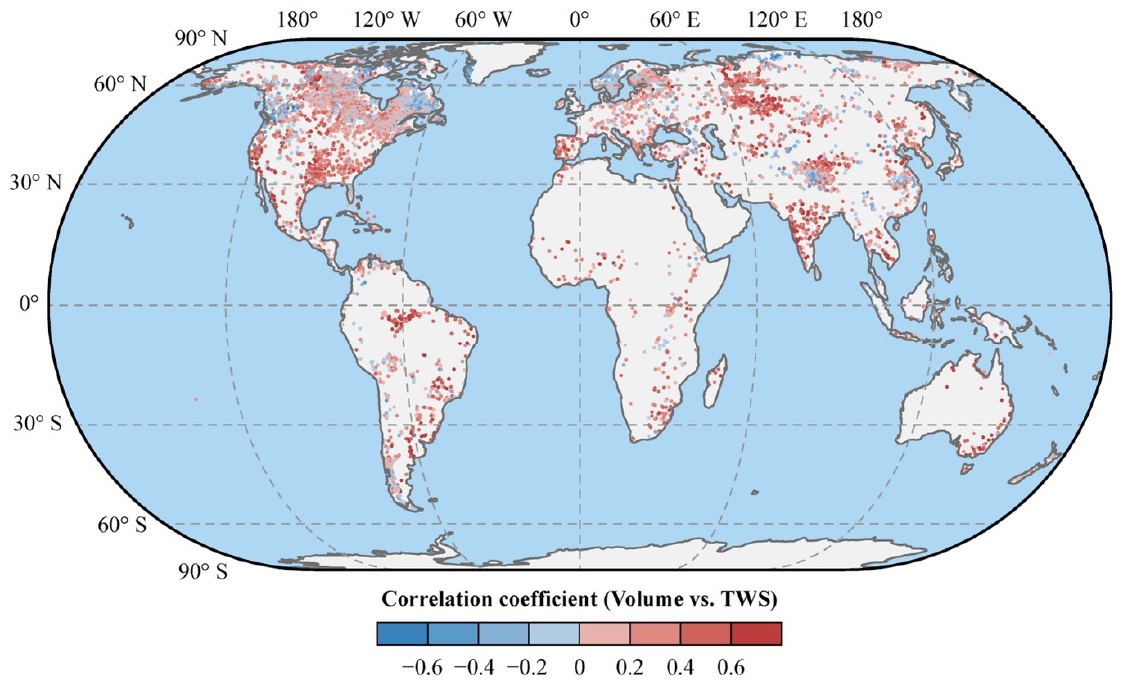
Figure 4. Correlations between monthly lake volume and TWS (terrestrial water storage measured by the GRACE satellite).